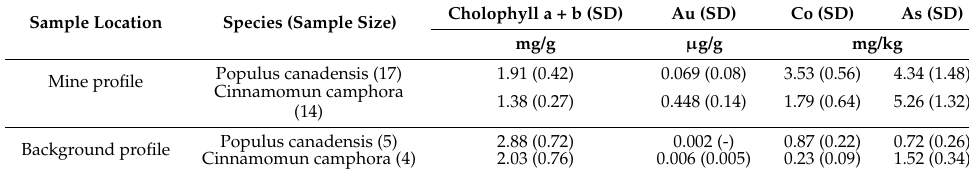
Table 6. The contents of cholophyll and